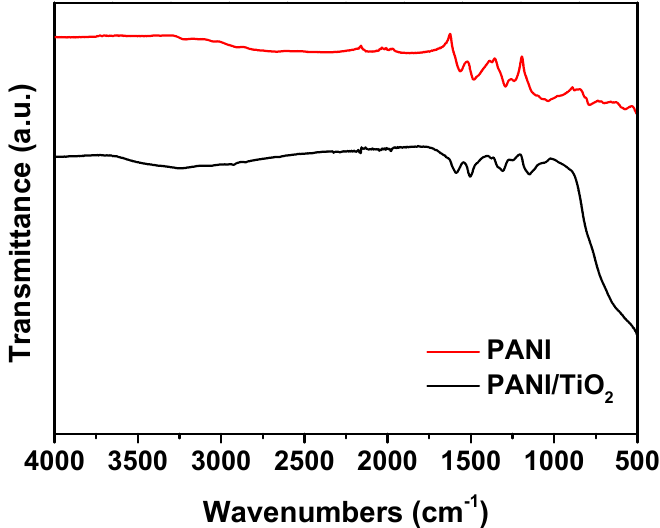
Figure 2. Fourier-transform infrared (FTIR) spectrum of prepared polyaniline (PANI) and PANI/TiO 2 composite.